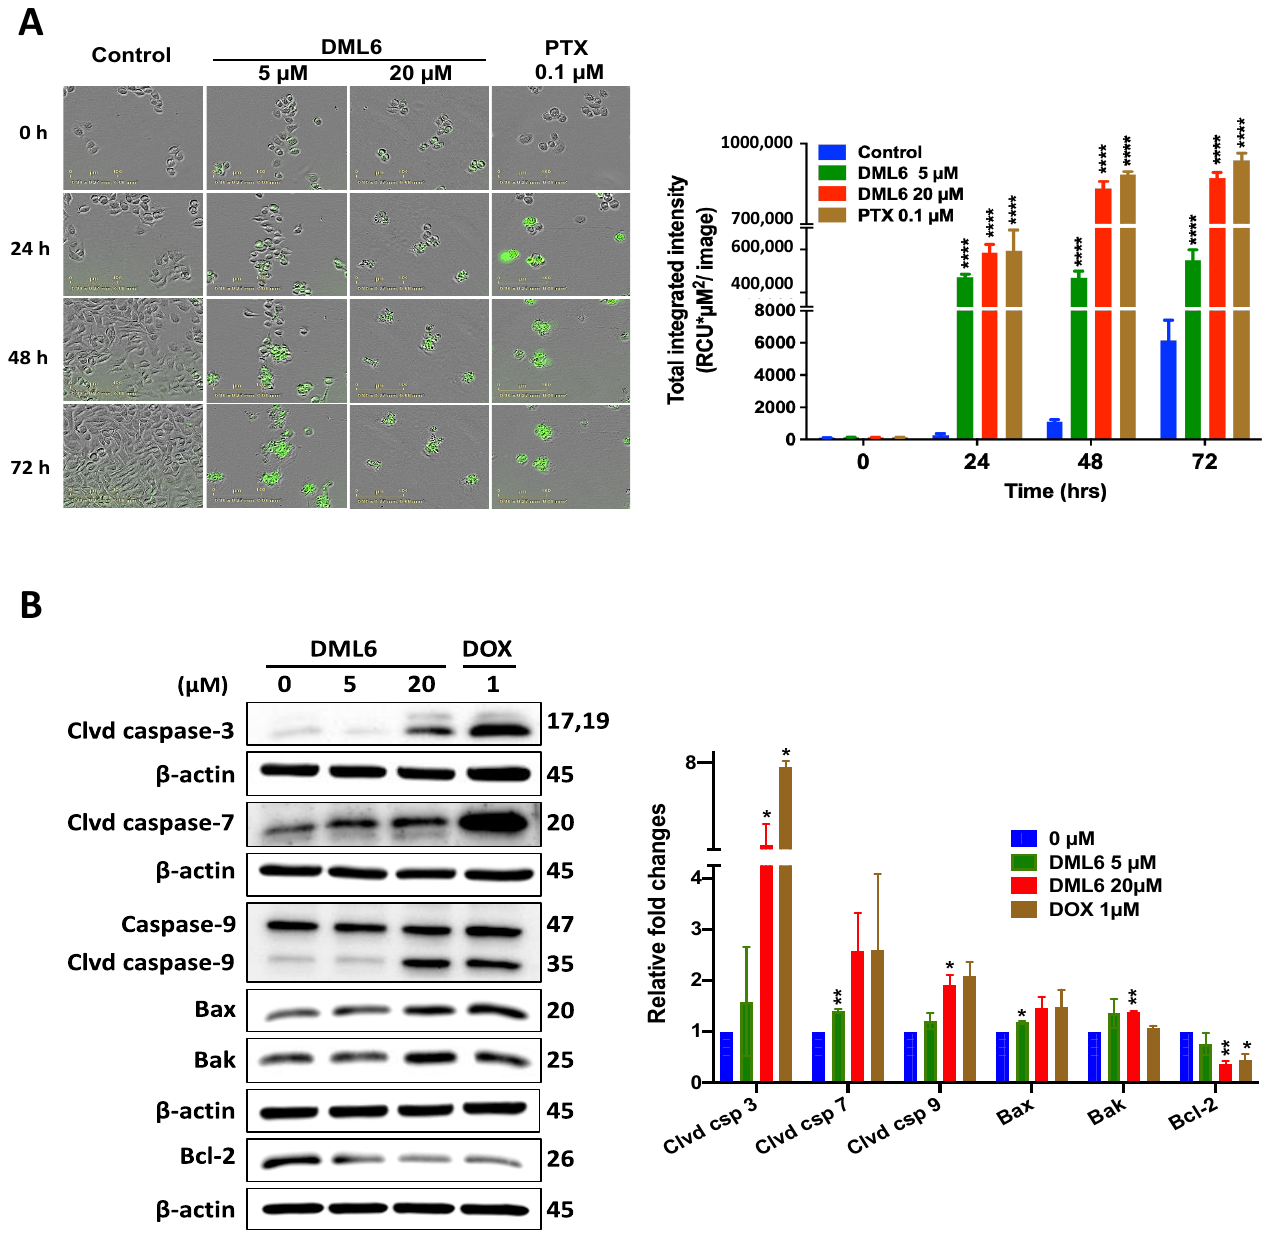
Figure 6. The effect of DML6 on the induction of intrinsic apoptosis. ( A ) Fluorescence time-dependent experiments to measure the effect of DML6 on the levels of apoptosis in OV2008 cells. Representative pictures of the fluorescence level of Cell Event™ Caspase-3/7 Green reagent after 24, 48, and 72 h of incubation. Bar = 100 µ m. A histogram quantitatively summarizing apoptosis induction at different times for the vehicle, 5 or 20 µ M of DML6 , is also shown. The data were analyzed using a two-way ANOVA analysis of variance, followed by Bonferroni multiple comparison test; **** p < 0.0001. ( B ) Western blots for the proteins cleaved caspase-3, cleaved caspase-7, caspase-9, cleaved caspase-9, Bax, Bak and Bcl-2, following overnight incubation with 20 µ M of DML6 . The values of the proteins were normalized to β -actin levels. A histogram summarizing the levels of each protein is also shown. All data are presented as the means ± SEM of four independent studies with * p < 0.05, ** p < 0.01 vs. control group. Clvd = cleaved; Csp =